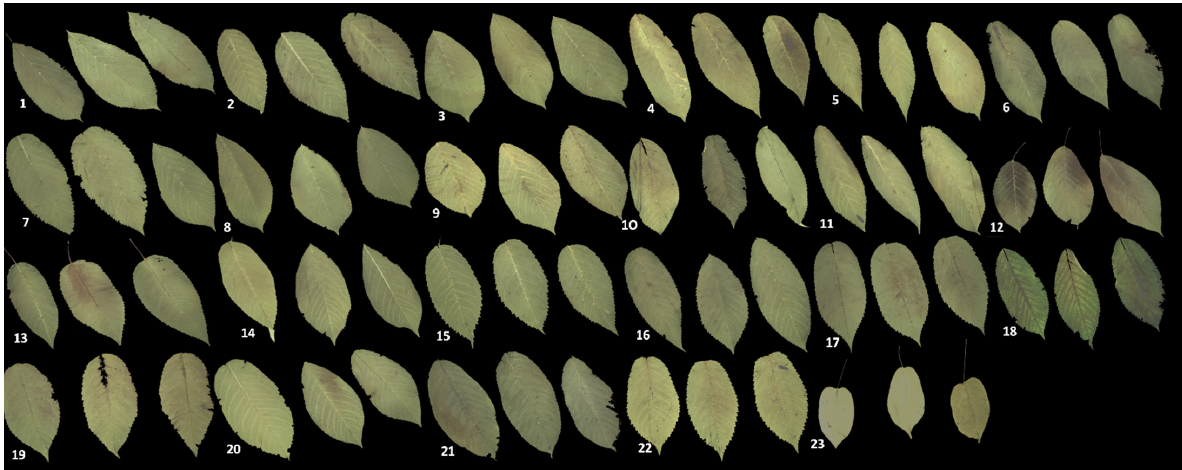
Figure 1. Images acquired from representative sweet cherry accessions (3 leaves per accession) at the mature leaf stage. Numbers 1–23 indicate the names of accession: ( 1 ) Bakirtzeika, ( 2 ) BxS5, ( 3 ) BxS14, ( 4 ) BxS17, ( 5 ) BxS19, ( 6 ) BxS21, ( 7 ) BxS22, ( 8 ) BxS33, ( 9 ) Chalkidos Anonimo, ( 10 ) Chiou, ( 11 ) HGXS11, ( 12 ) Lemonidi, ( 13 ) Mieza, ( 14 ) Petrokeraso Tragano Achaias, ( 15 ) Proimo Kolindrou, ( 16 ) Tragana Edessis-Naousis, ( 17 ) Tragana Edessis, ( 18 ) Tragana Rodohoriou, ( 19 ) Tsolakeika, ( 20 ) Vasiliadi, ( 21 ) TrXAg1, ( 22 ) Wild cherry, ( 23 ) Prunus mahaleb .